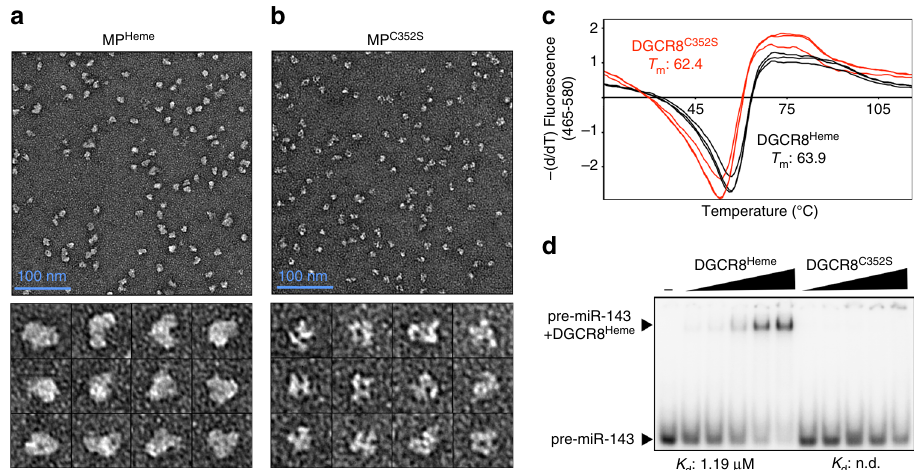
Fig. 4 Heme induces a conformational switch in DGCR8 that facilitates RNA binding. a , b Representative negative stain electron micrographs of a MP Heme and b MP C352S after crosslinking with glutaraldehyde, with zoomed-in view of the selected particles shown underneath. c Thermal denaturation of DGCR8 in heme-saturated vs. heme-de fi cient states shows that the melting temperature ( T m ) increases by 1.5 °C in the presence of heme. d EMSA with 5 ′ end-labeled pre-miR-143 shows that DGCR8 Heme binds with an increased af fi nity compared to that of the DGCR8 C352S mutant. “ − ” lane contains no protein. Protein concentrations are (left to right): 0.13, 0.26, 0.52, 1.04, and 2.08 μ